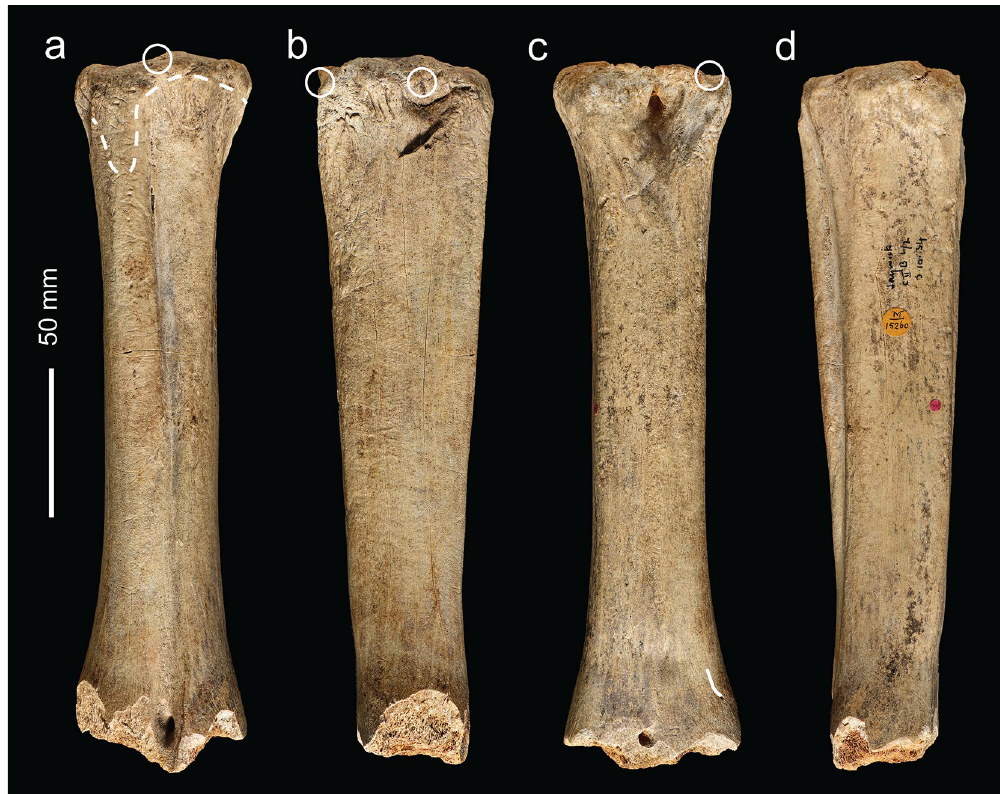
Figure 3. Bovid metatarsal (NHMUK PV M 15260) used as a knapping hammer in dorsal ( a ), medial ( b ), plantar ( c ) and lateral ( d ) view. The area of battering on the dorsal face is bounded by the dashed line, and the circles indicate the points of impact that detached flakes of bone from the proximal end. The cut-mark is indicated by the white